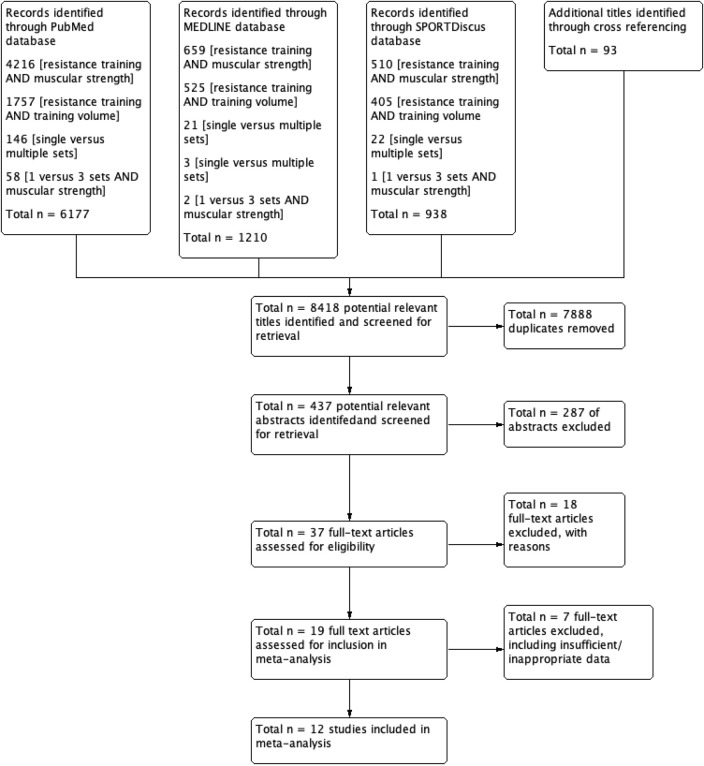
The flow of journal articles through the systematic review process.